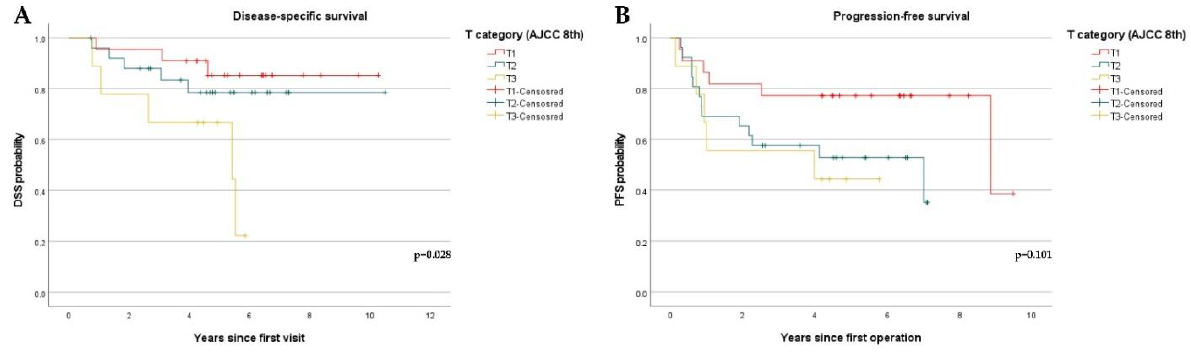
of the AJCC. (T1, n = 35, T2, n = 22); ( B ) PFS curves stratified by T category based on the 7th edition of AJCC. (T1, n = 35, by T category based on the 7th edition of AJCC. (T1, n = 35, T2, n = 22). T2, n = 22).